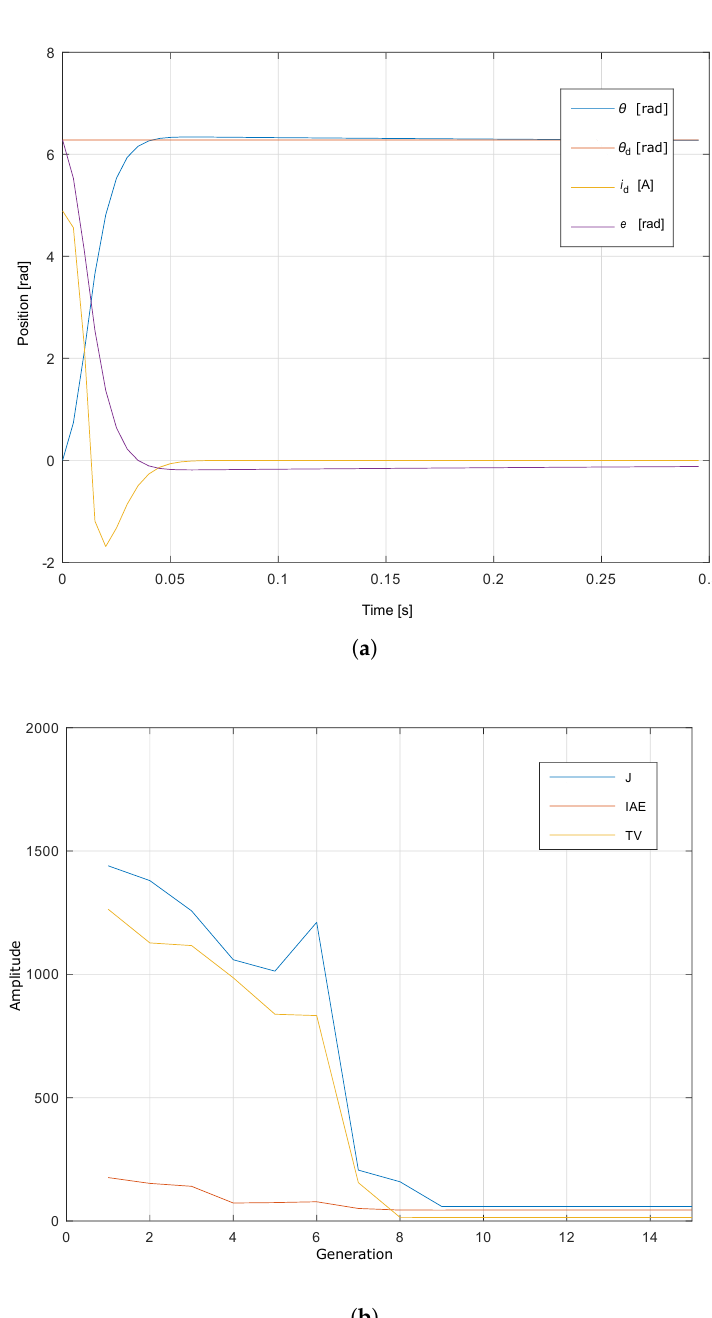
Figure 9. Response of GA self-tuning PID controller. ( a ) Angular position, current and error of test bench. ( b ) Objective function through